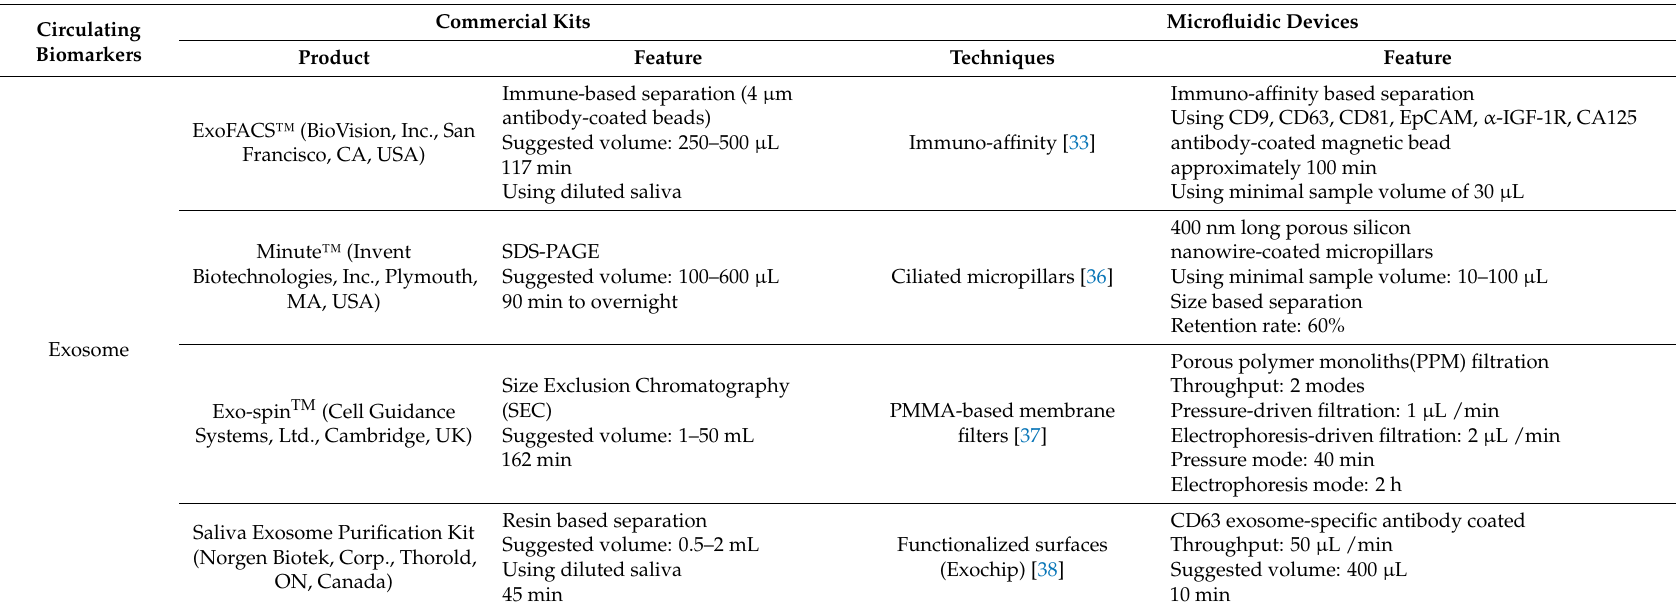
Table 1. Applicable technologies for isolation of circulating biomarkers in